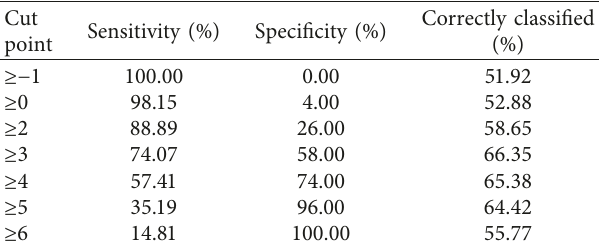
Table 5: Diagnostic accuracy and cut-offs for intraocular pressure.